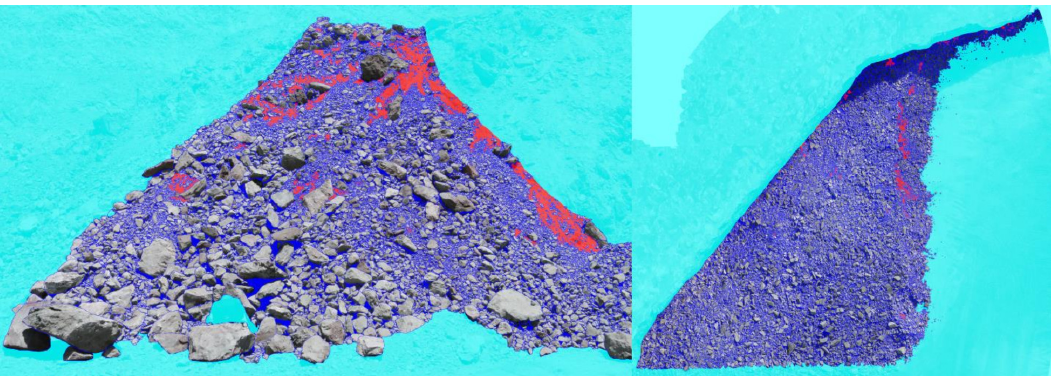
Figure 10. Rock fragment delineation for Mine A ( left ) and Mine B ( right ). Blue regions represent rock fragment boundaries; cyan regions are masked; and red regions represent